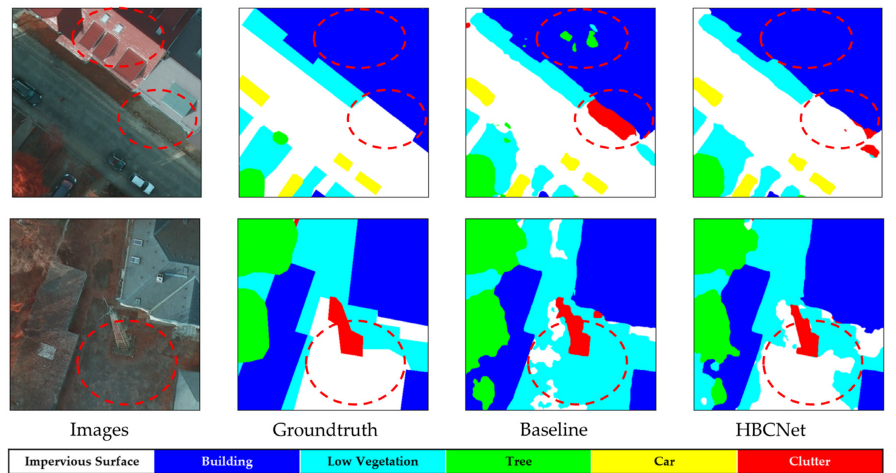
Figure 8. Qualitative comparisons between the baseline and our method. (From left to right ) Columns show the original images, the image ground truth, the predictions of baseline and the predictions of